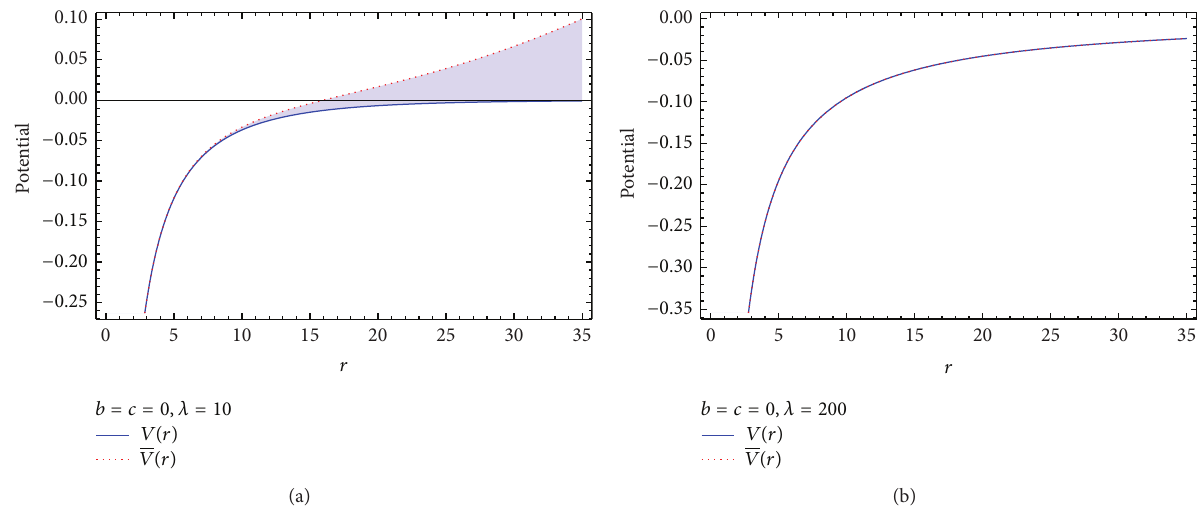
Figure 1: (a) Comparison of 𝑉(𝑟) and 𝑉(𝑟) potentials in case of 𝑏 = 𝑐 = 0 and 𝜆 = 10 (in arbitrary units). (b) Comparison of 𝑉(𝑟) and 𝑉(𝑟) potentials in case of 𝑏 = 𝑐 = 0 and 𝜆 = 200 (in arbitrary units).